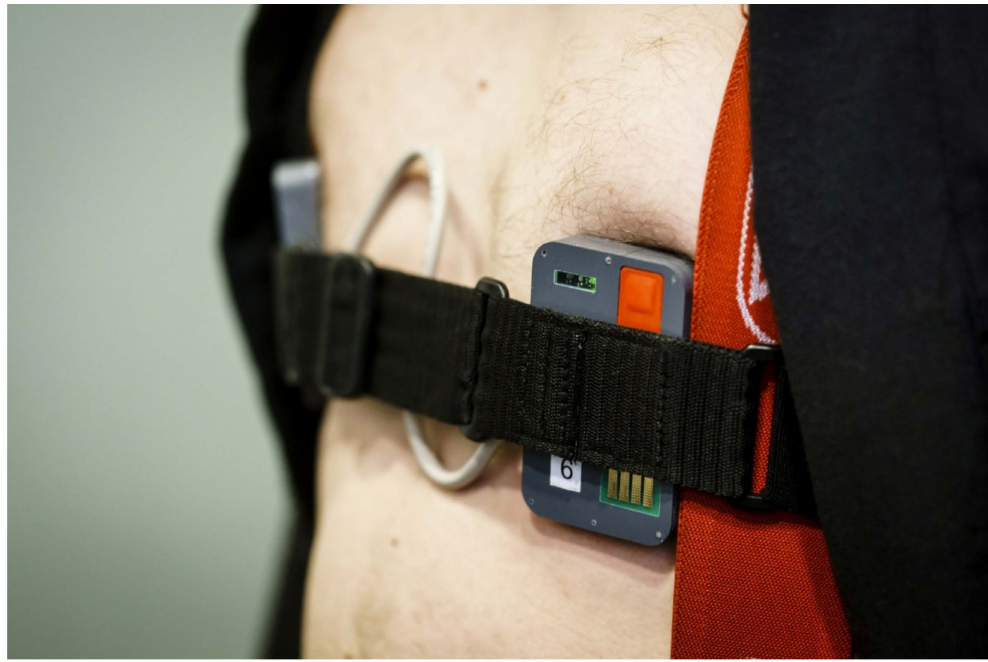
Figure 3. Chest belt of the FlexiGuard monitoring unit used during the